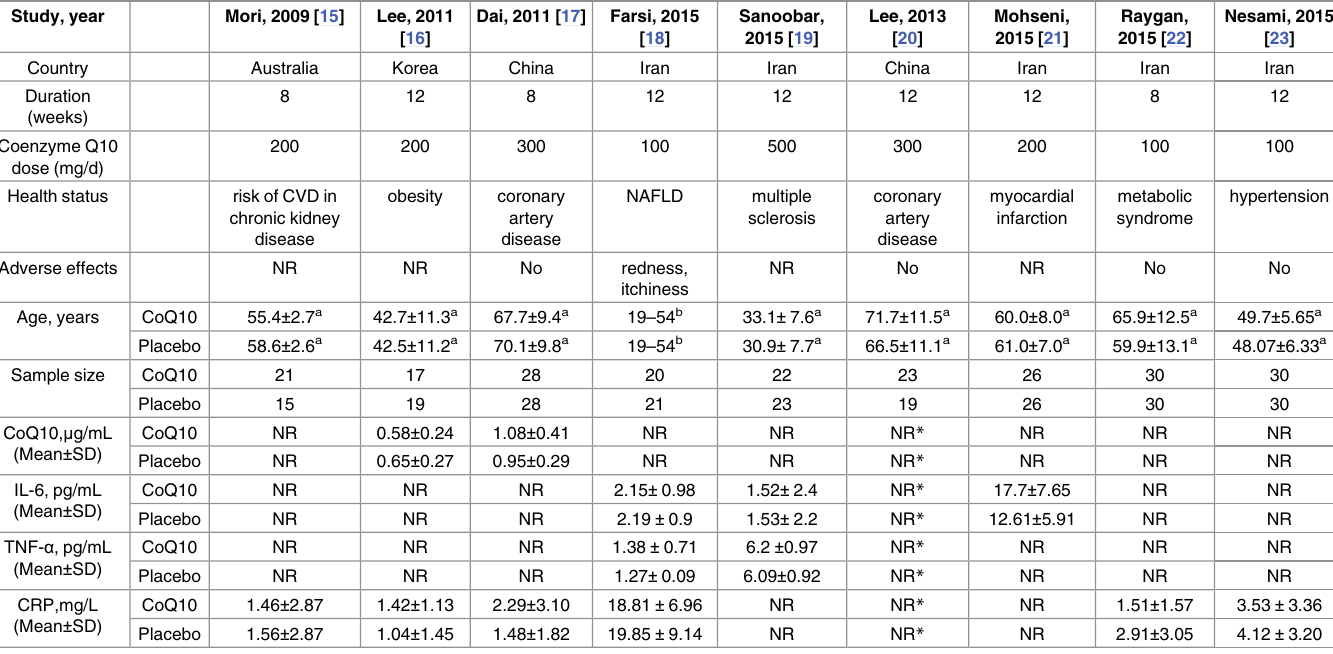
Table 1. The characteristics of included studies in this